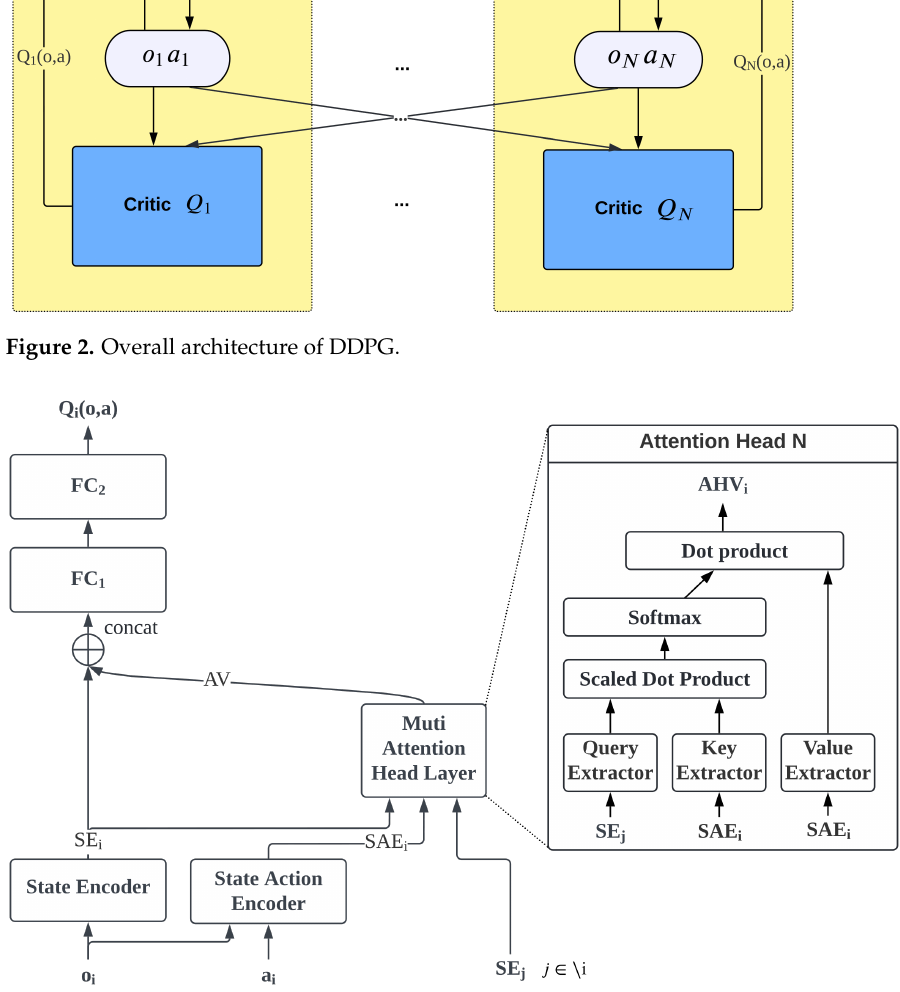
Figure 3. Critic network of